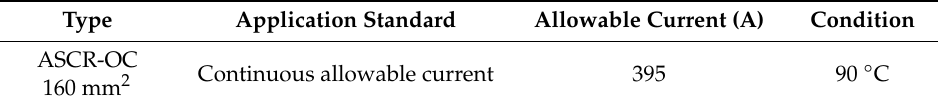
Table 4. Technical specifications of the distribution line.